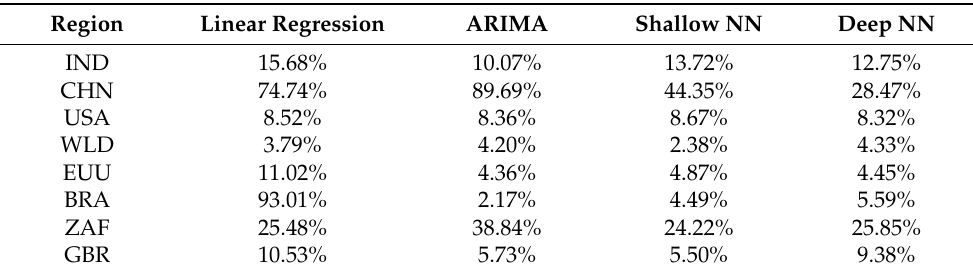
Table 4. The mean average percentage error (MAPE) on the test set, per region and model, is under a polynomial degree of